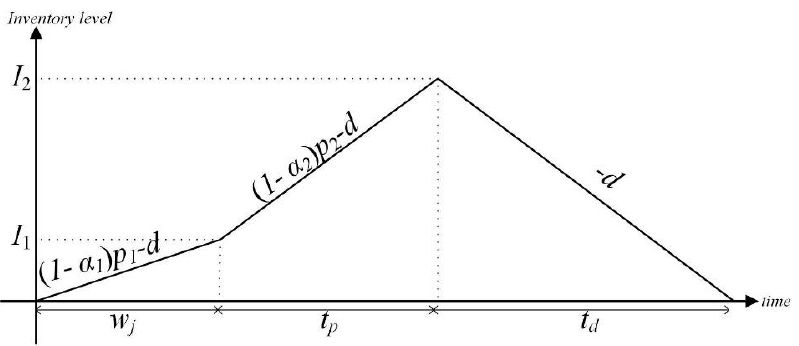
Figure 1. Scrap model inventory level, including scrap items.